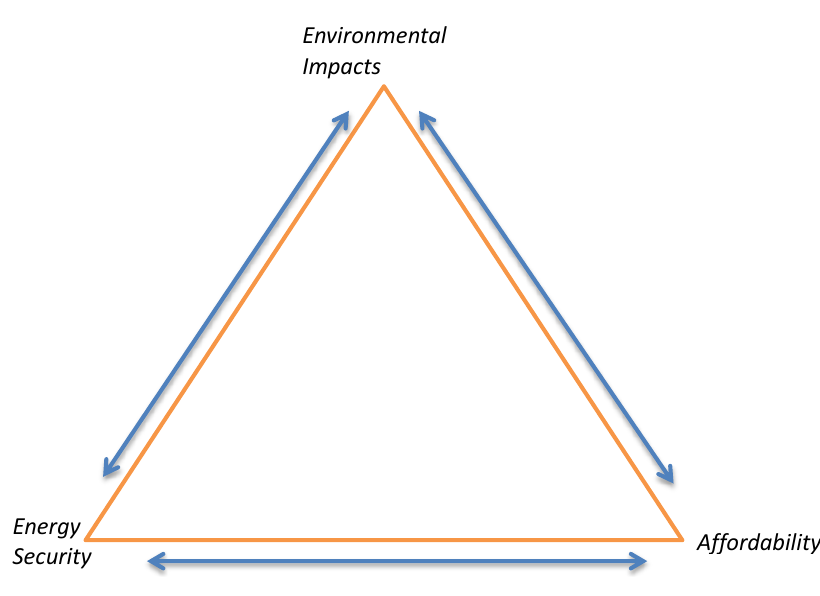
Figure 1. The energy trilemma.